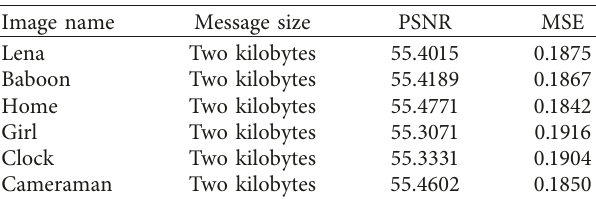
Table 2: Performance analysis of the proposed method using (256 256) images. ∗